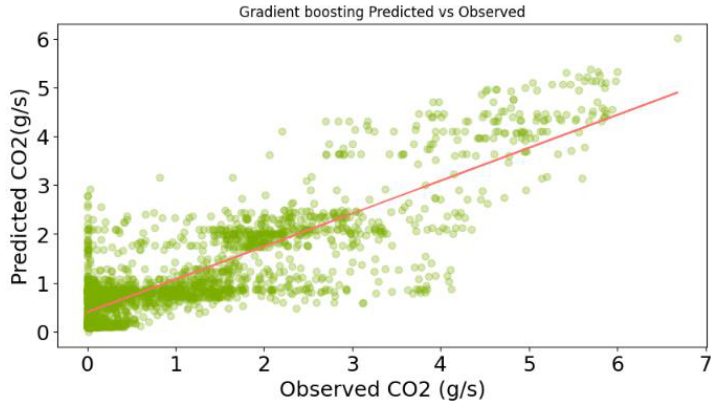
Figure 8. Predicted vs. observed CO 2 emission from LPG vehicle.